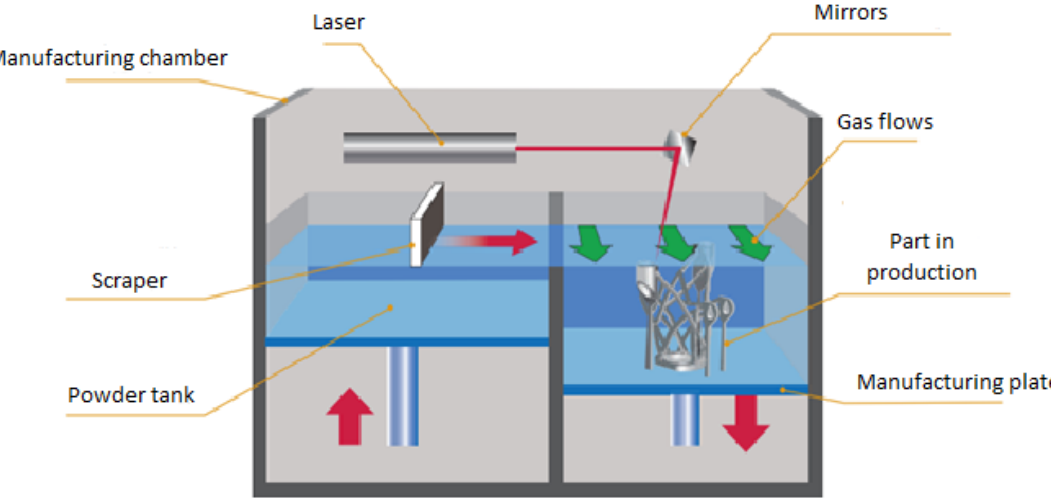
Figure 1. Operating scheme of the SLS process.